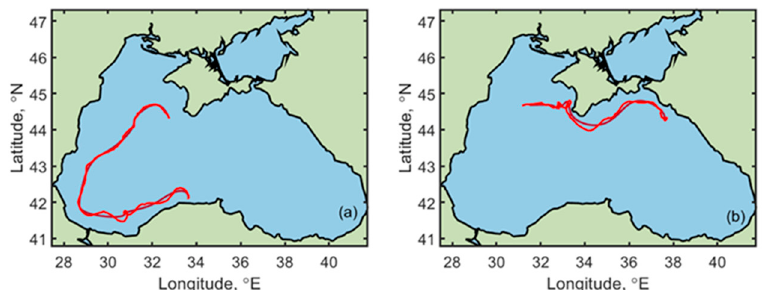
Figure 4. Comparison of the mean Lagrangian and observed trajectories for drifters #16330 ( a ) and #33347 ( b ) deployed in the Black Sea. Black and red are observed and mean Lagrangian trajectories, respectively.